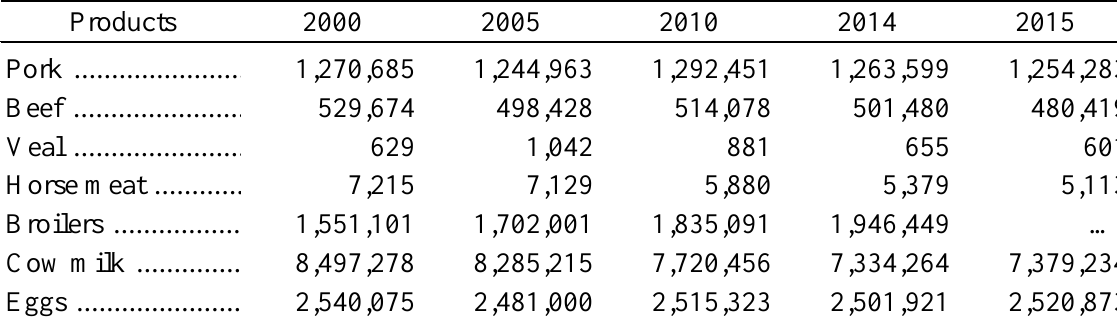
Table 5.3 Production of Meat, Milk and Eggs Products